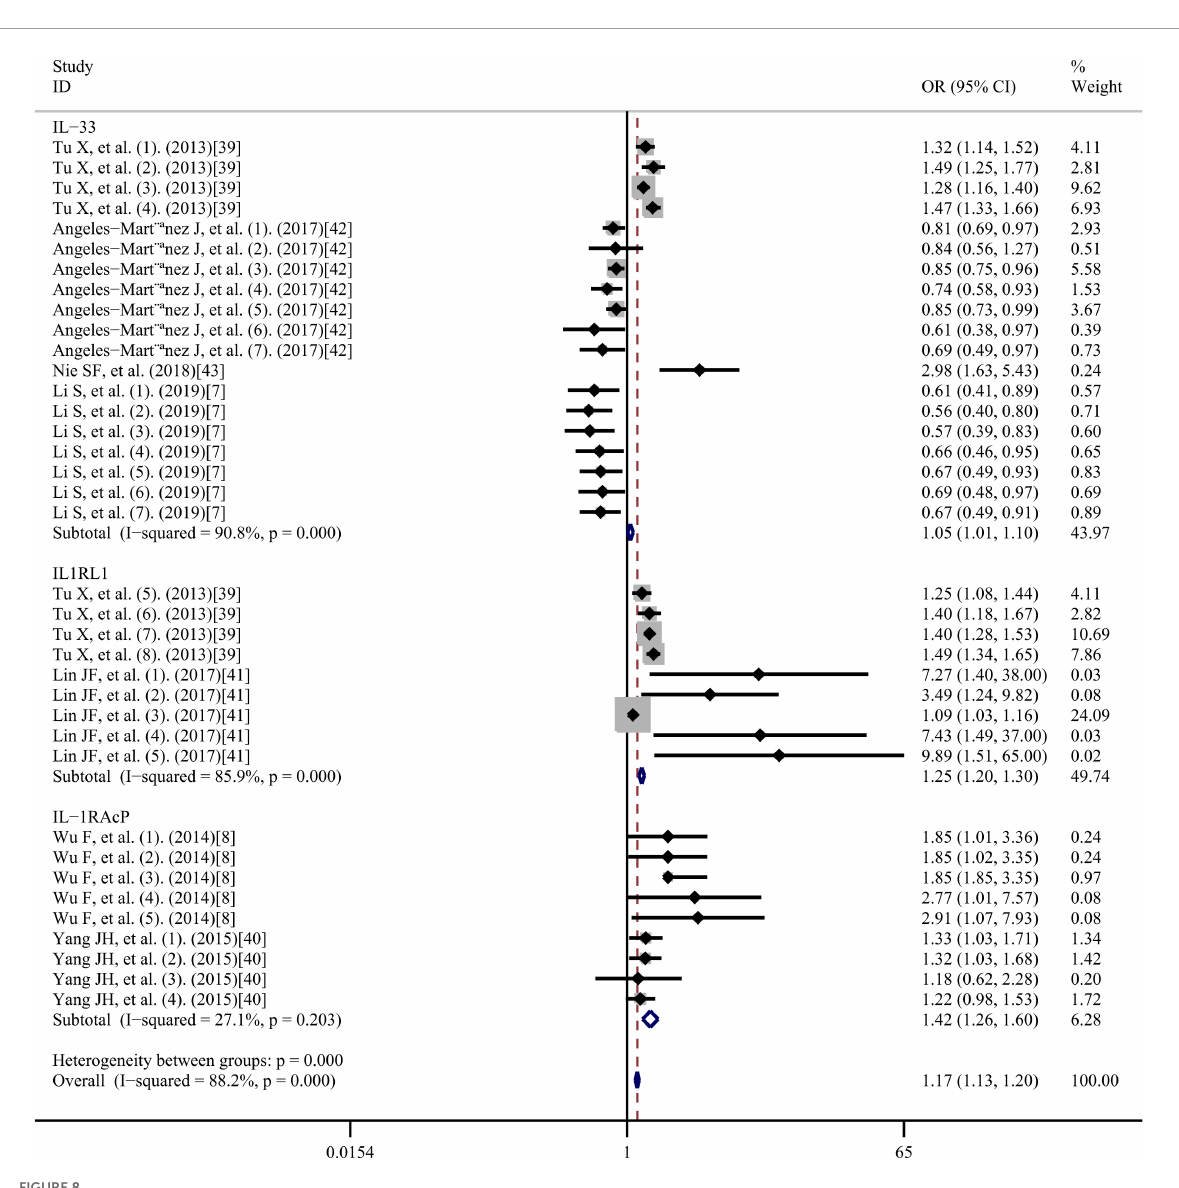
FIGURE8 Sensitivity analysis of the association between IL-33/ST2 and coronary artery